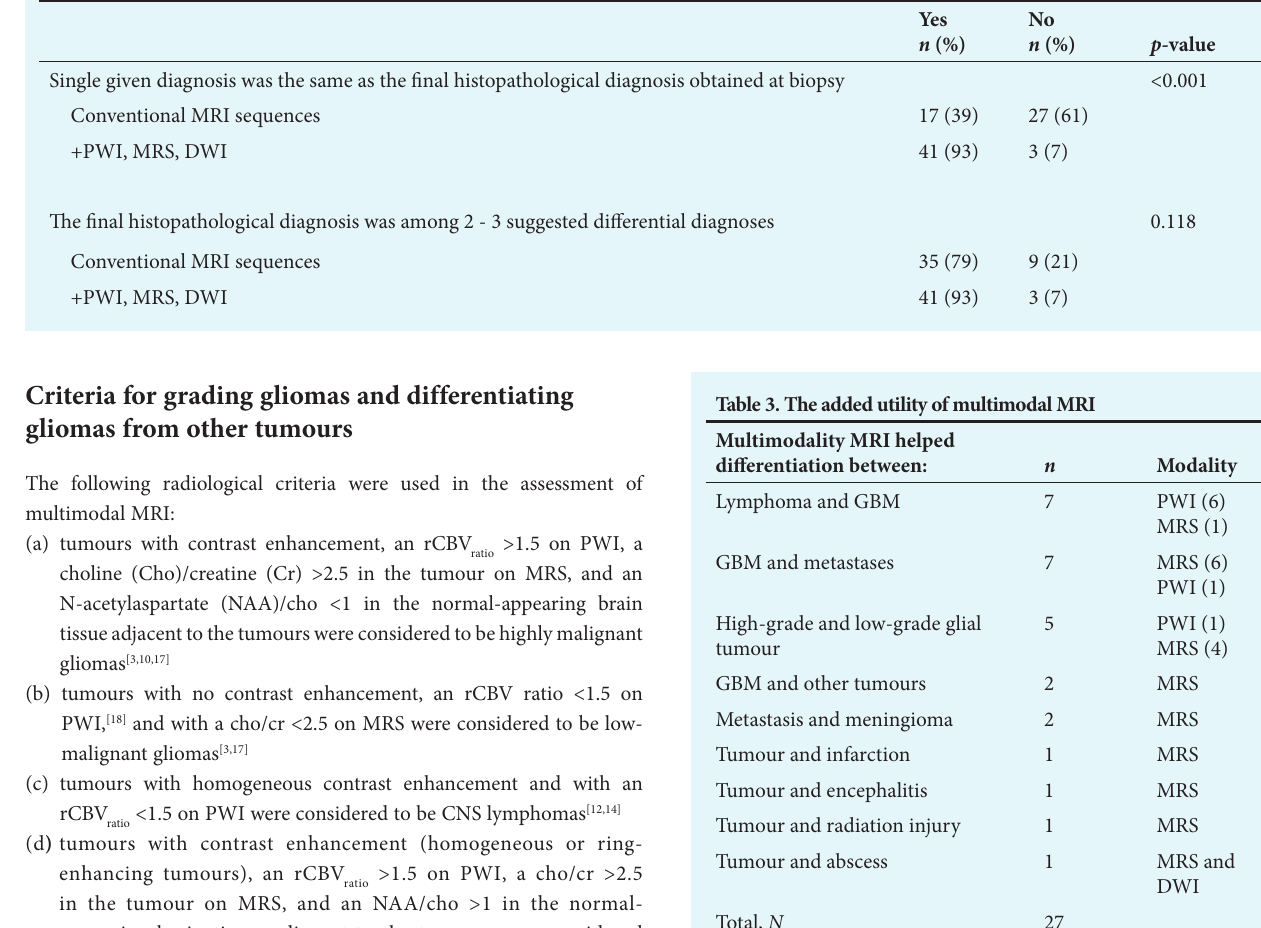
Table 2. Compatibility of the diagnosis provided by conventional MRI sequences and multimodal MRI with the diagnosis obtained at biopsy